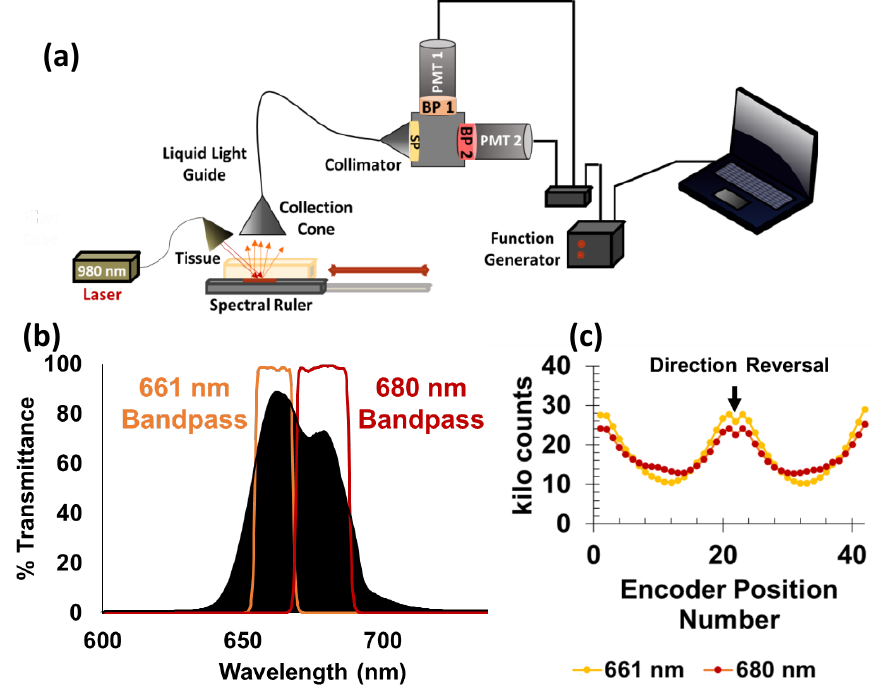
Figure 5. ( a ) Schematic of the fiber guided experimental setup. The sensor is excited with fiber-coupled 980 nm light, and the emission is collected with an optical fiber that passes through an 842 nm short-pass filter before reaching a 50/50 beam splitter housed within a filter cube. The beam splitter directs the light through either one optical arm with a 661 nm bandpass and PMT photodetector or a second arm with a 680 nm bandpass and second PMT. ( b ) Sensor upconversion spectrum overlaid with bandpass filter transmission spectra. ( c ) Average intensity vs. encoder position (a 100 µm encoder displacement was performed between each position). Each data point calculated from the average of a hundred 1.0 s measurements at a fixed position. The motorized stage direction was reversed after 2.0 mm of travel. Zoom in of 5c with error bars is shown in Supporting Info Figure S2a.